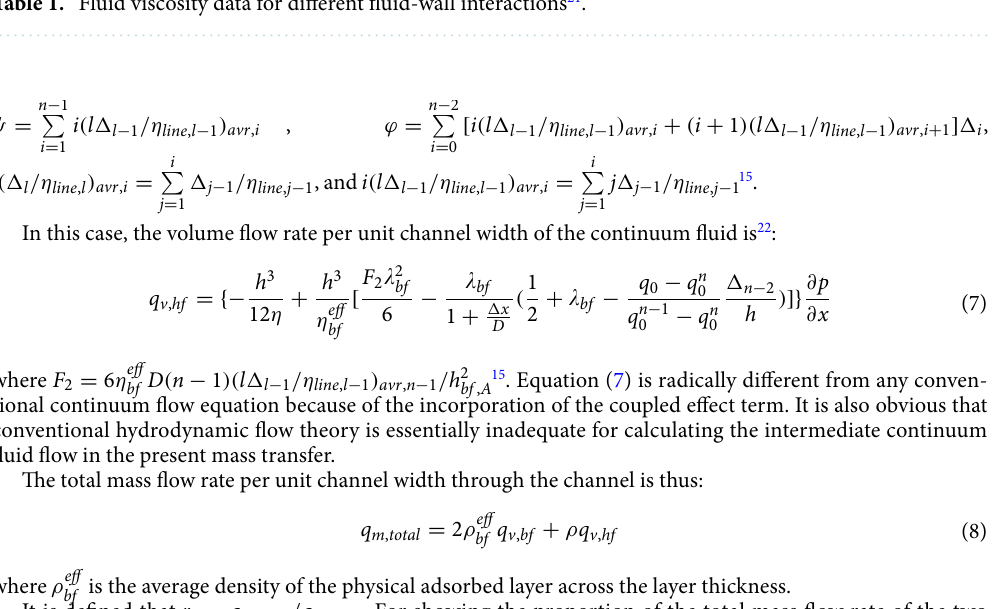
Table 1. Fluid viscosity data for different fluid-wall interactions 21